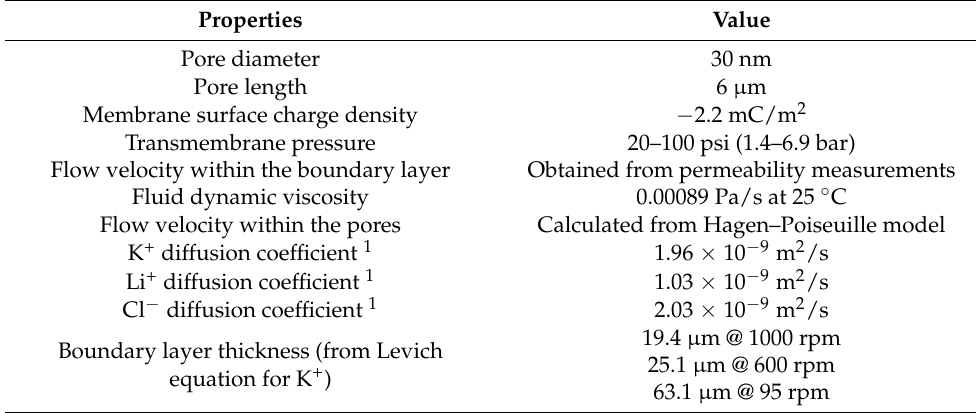
Table 1. Simulation